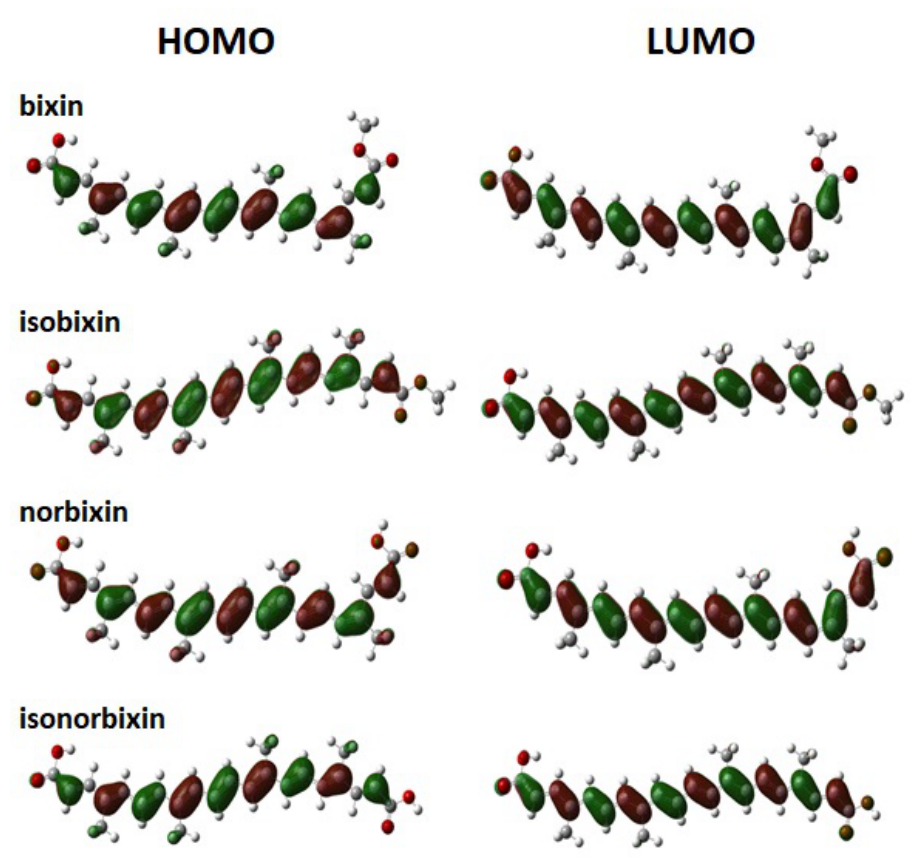
Figure 4. Schematic representation of the frontier molecular orbitals HOMO (left) and LUMO (right) of the molecular dyes in chloroform solution. These results were obtained by employing the CAM-B3LYP/6-31+G(d,p) level of